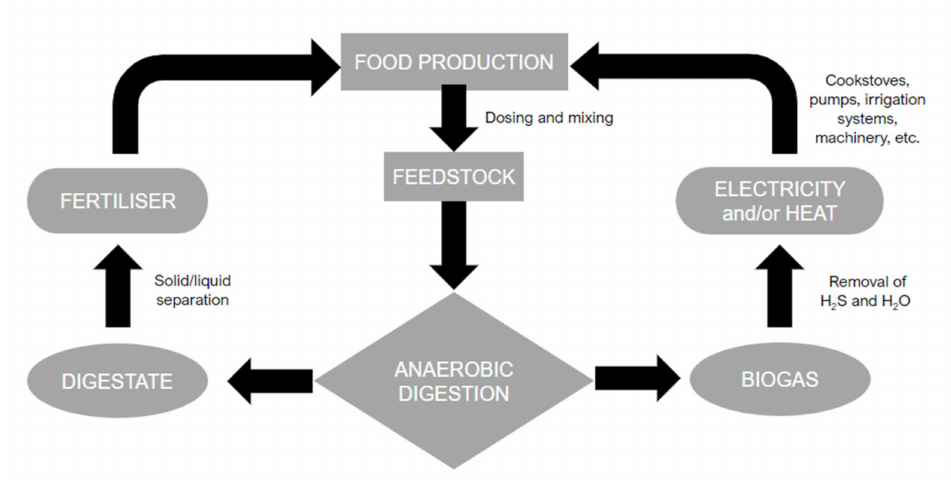
Figure 1. A summary flow diagram of anaerobic digestion on a closed-loop system on